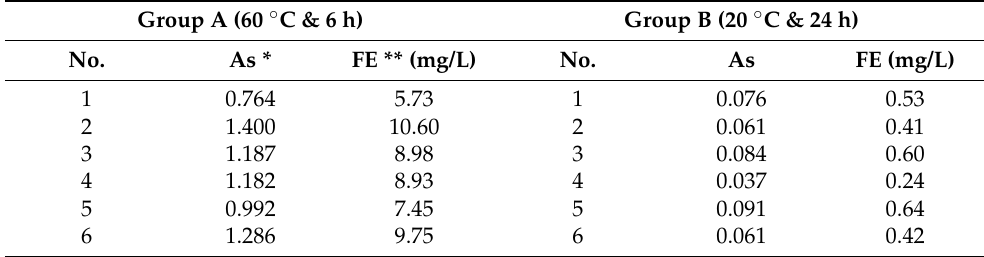
Table 2. Formaldehyde emissions data measured by the desiccator at 60 ◦ C for 6 h and 20 ◦ C for 24 h. Group A (60 ◦ C & 6 h) Group B (20 ◦ C & 24 h) No. As * FE ** (mg/L) No. As FE (mg/L) 1